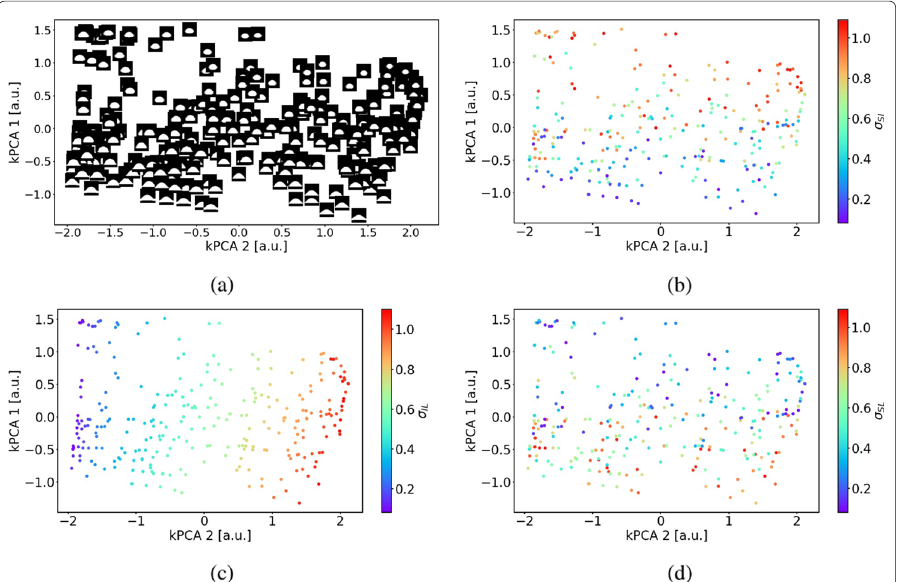
Fig. 9 Correlation of the microstructures in the dataset with the three interface energy parameters. ( a ) VAE latent space representation of all microstructures, ( b ) Solid-IMC interface energy ( σ SI ), ( c ) IMC-Liquid interface energy ( σ IL ), and ( d ) Solid-Liquid interface energy ( σ SL ) from the validation set. For interpretation of the colors in this figure refer to the online version of this